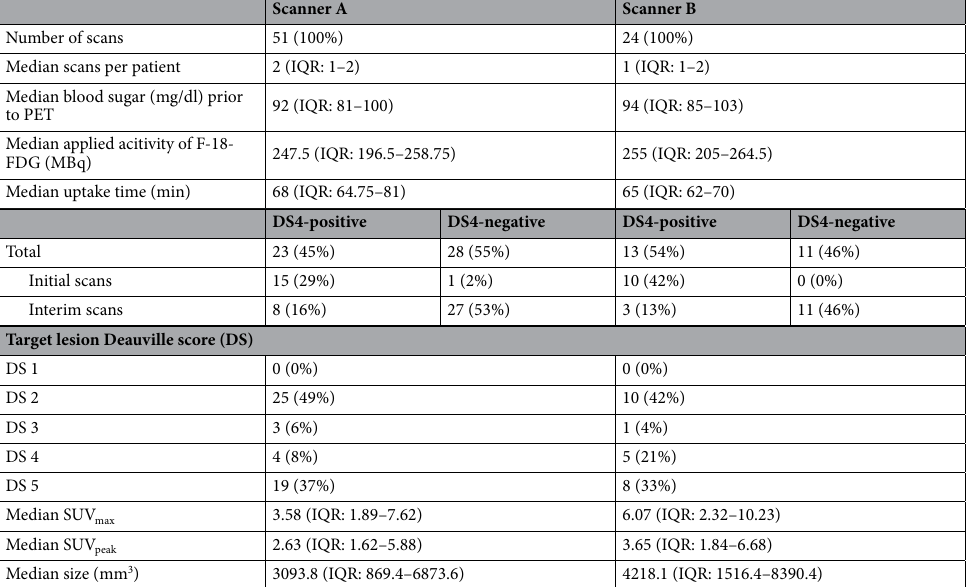
Table 2. Patient-related examination details and distribution of Deauville Scores. Details of the patient-related examination details and the distribution of the Deauville Scores. Percentages of the scans are listed scanner- wise and may not total 100 due to rounding. IQR interquartile